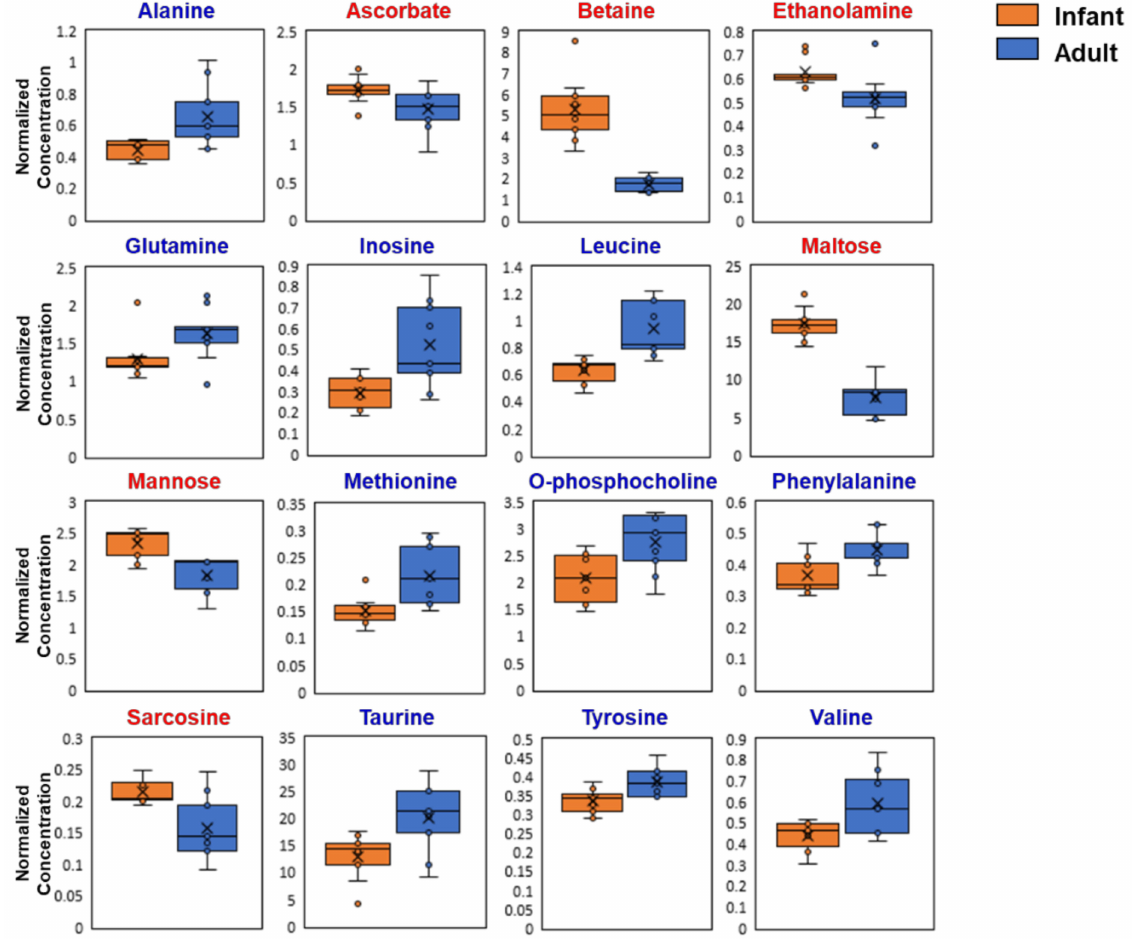
Figure 4. Boxplot of the statistically important hepatic metabolites ( p < 0.05) in infant (3-week-old, n = 9) and adult (9-week-old, n = 9) male mice. Metabolites written in red letters are higher in the infants, while those in blue letters are higher in the